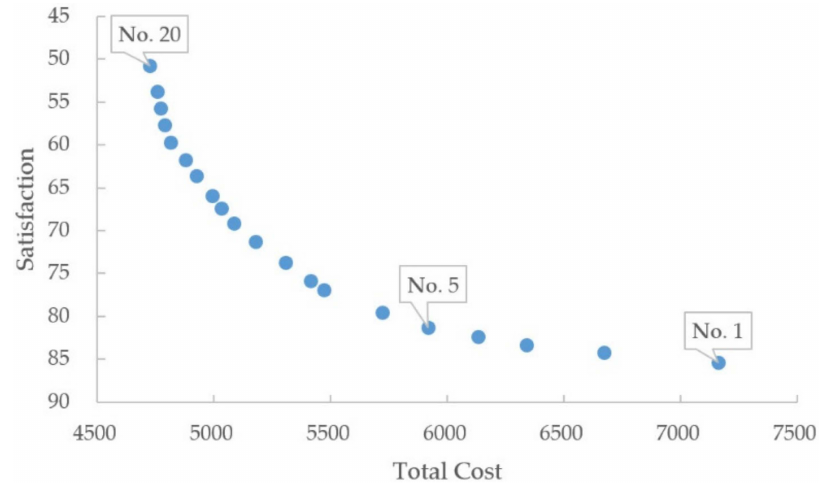
Figure 8. Distribution of 100 customers’ Pareto-optimal front. Table 4. Evaluation of results using the TOPSIS